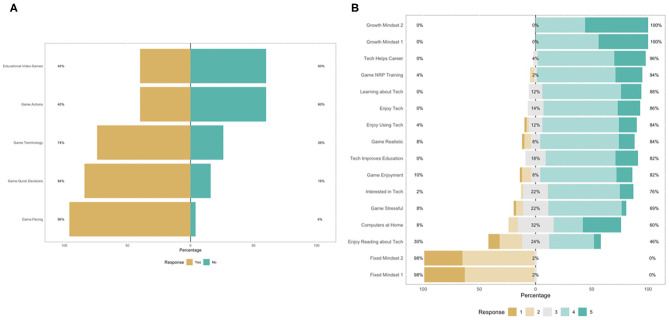
The binary (A) and 5-item Likert (B) survey items.